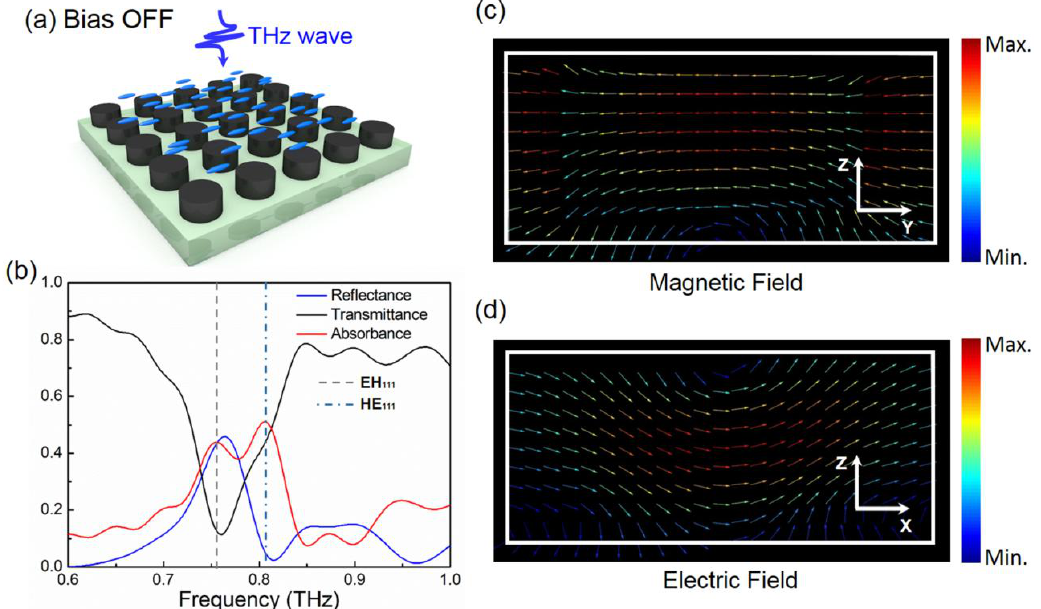
Figure 3. ( a ) The LC orientation in the bias OFF state. ( b ) Simulated spectra of reflectance, transmittance, and absorbance at bias OFF state. The ( c ) magnetic field of a single unit in the y - z plane at 0.81 THz. and the ( d ) electric field in the x - z plane at 0.76 THz.